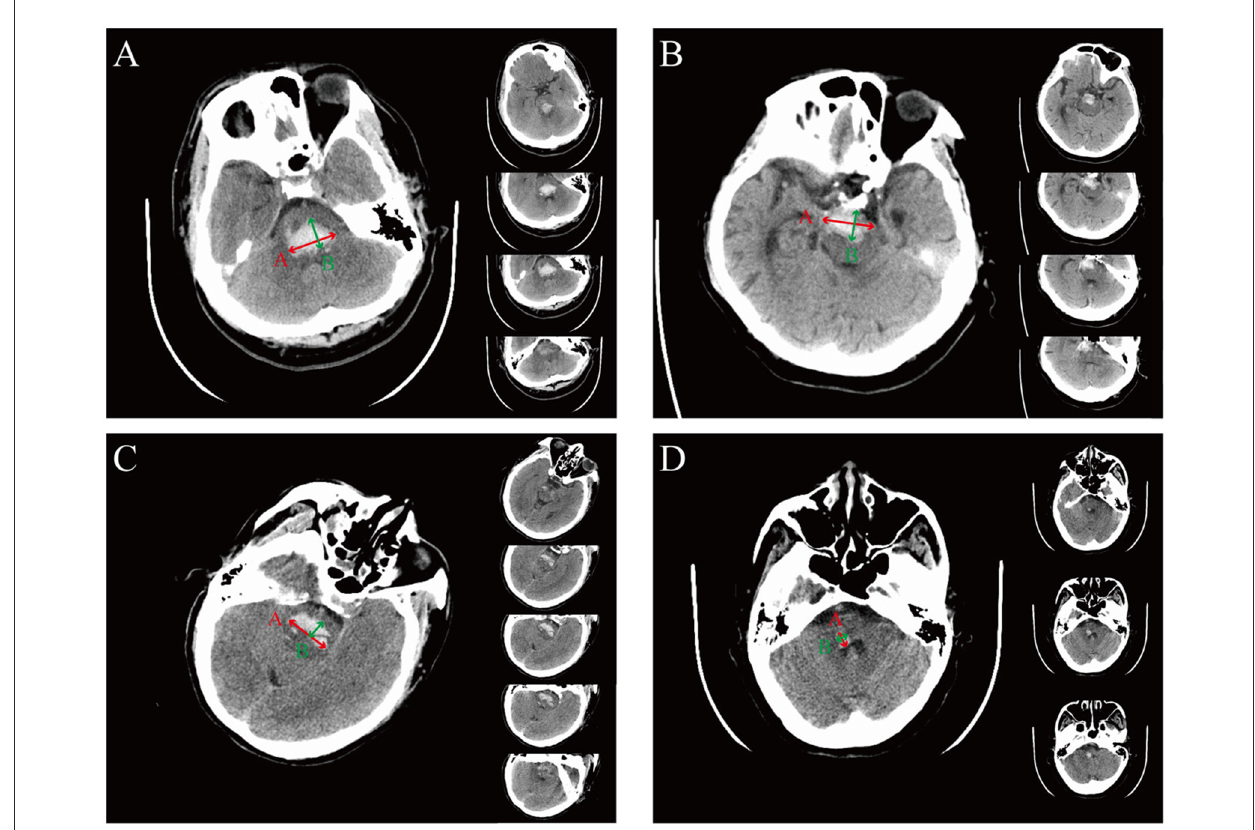
FIGURE1 The representation of the ABC formula for calculating hemorrhage volume in different hemorrhagic locations. (A) Representative images of dorsal hematoma. The A value is defined as the longest segment (red arrow) in the largest hematoma slice, the B value is defined as the longest segment, which is perpendicular to the A segment on the same slice (green arrow), and the C value is defined as the approximate number of CT slices (right panel) with the slice thickness (being 0.5cm in this example). For this example, (A × B × C)/2 = [3.2 × 1.9 × (4 × 0.5)]/2 = 6.08 cm 3 . (B) Representative images of ventral hematoma. For this example, (A × B × C)/2 = [3.1 × 1.5 × (4 × 0.5)]/2 = 4.65 cm 3 . (C) Representative images of hematoma crossing the midline. For this example, (A × B × C)/2 = [3.1 × 1.1 × (5 × 0.5)]/2 = 4.26 cm 3 . (D) Representative images of hematoma without crossing the midline. For this example, (A × B × C)/2 = [0.9 × 0.7 × (3 × 0.5)]/2 = 0.47 cm 3